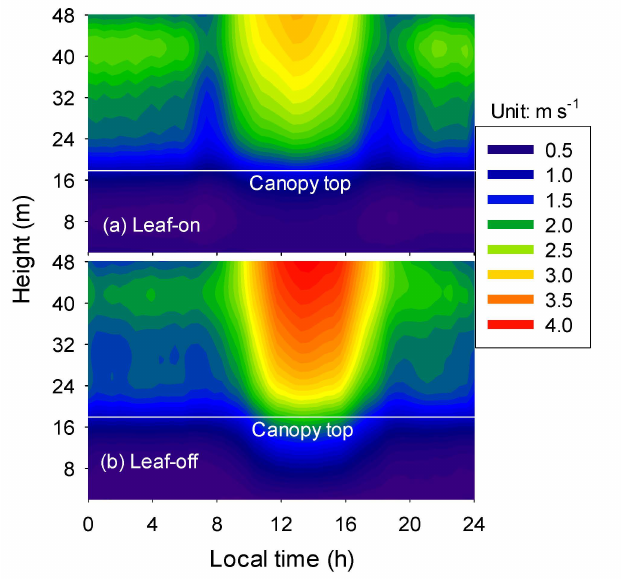
Figure 2. Diurnal courses of horizontal wind velocity profile during the leaf-on ( a ) and leaf-off ( b ) seasons of